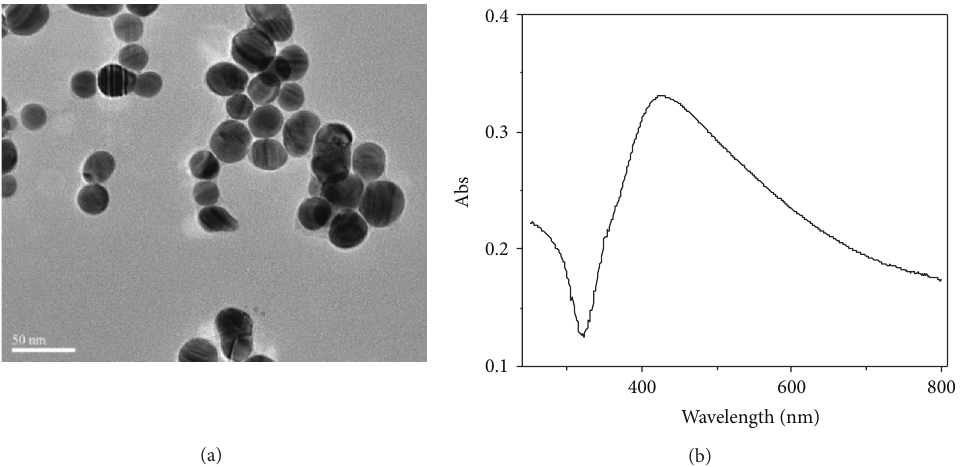
Figure 1: (a) TEM image of Ag@SiO 2 . (b) UV-vis spectrum of Ag@SiO 2 .